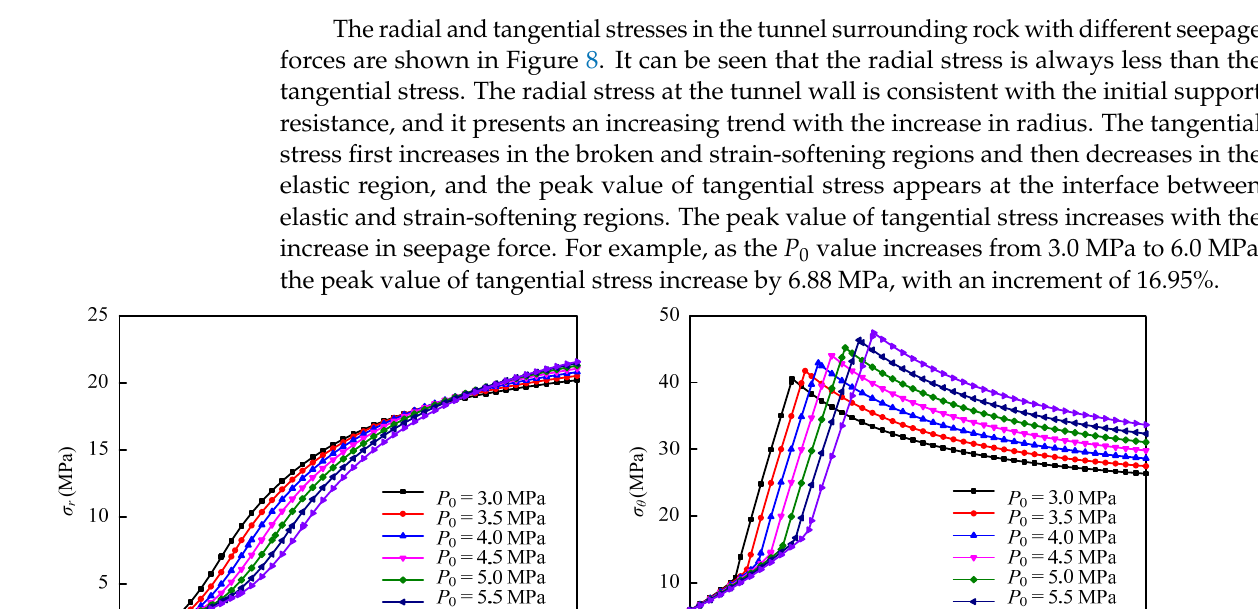
Figure 7. Effect of seepage force on the radii of strain-softening and crushed regions and surface displacement. ( a ) R s and R c ; ( b ) u 0 .